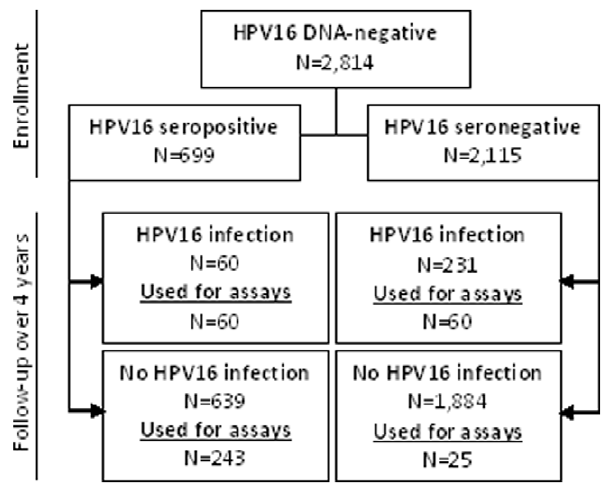
Figure 1. Consort diagram of the study population and targeted sampling strategy for HPV16 serological assays study. Out of the 639 women, who were HPV16 seropositive by ELISA at enrollment and did not develop HPV16 infection over follow-up in the population, 35 did not have enough sample volume for testing and were excluded when drawing